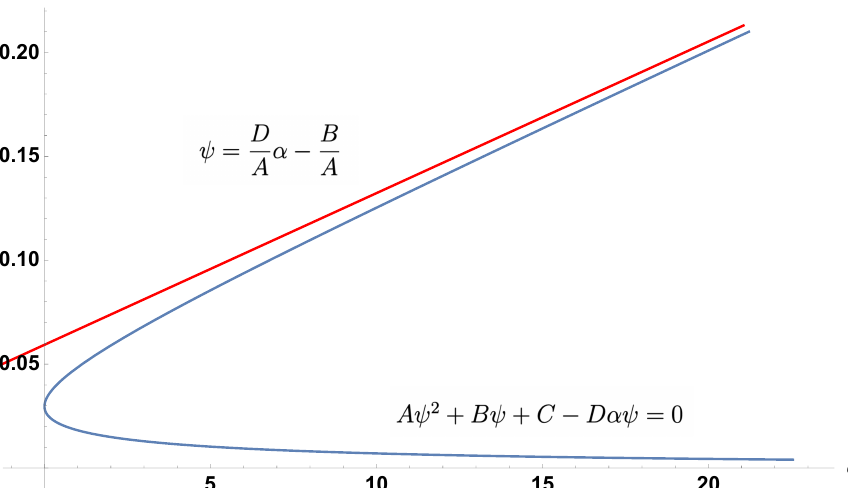
Figure 2. The slant asymptote (in red) and the degenerate hyperbola (in blue), using parameter values set to “sample value” from the “revised” column of Table